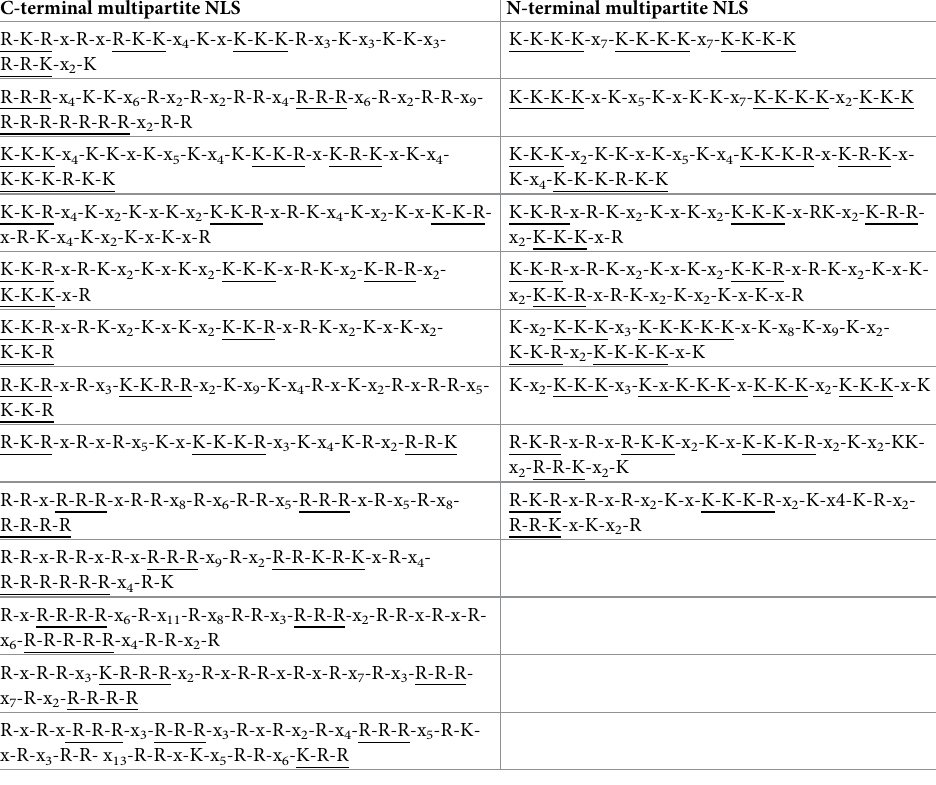
Table 2. Putative multipartite nuclear localization signal sequences of NAC transcription factor proteins. The underlined amino acids are designated as NLS and letter x denoted as any amino